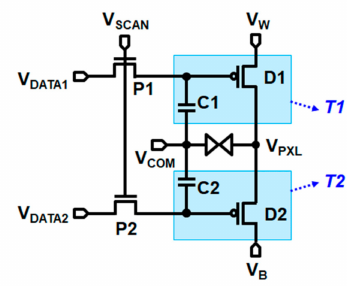
Figure 2. Circuit diagram of the proposed memory-in-pixel (MIP)